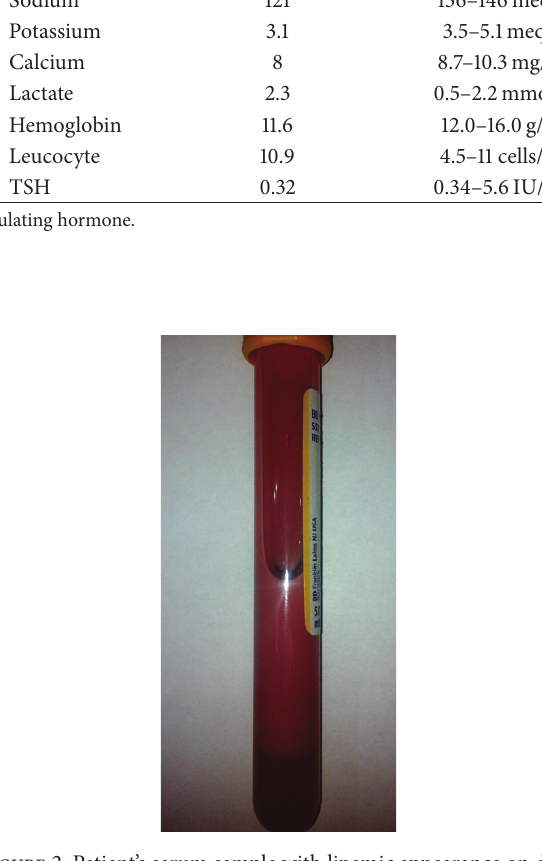
Figure 2: Patient’s serum sample with lipemic appearance on day 1 of